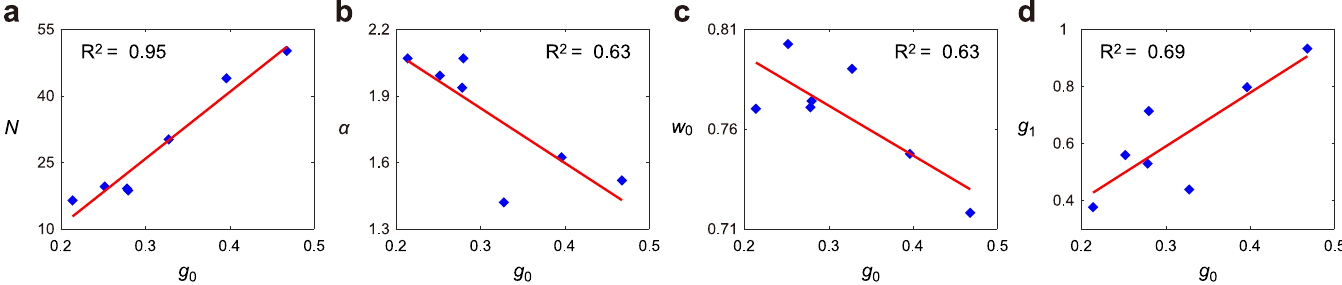
Fig 6. Connection between the estimated model parameters of model II. A : Scatter plot of the estimated N versus the estimated g 0 under seven growth conditions. B : Scatter plot of the estimated α versus the estimated g 0 . C : Scatter plot of the estimated w 0 versus the estimated g 0 . D : Scatter plot of the estimated g 1 versus the estimated g 0 . The red lines shown in A-D are regression